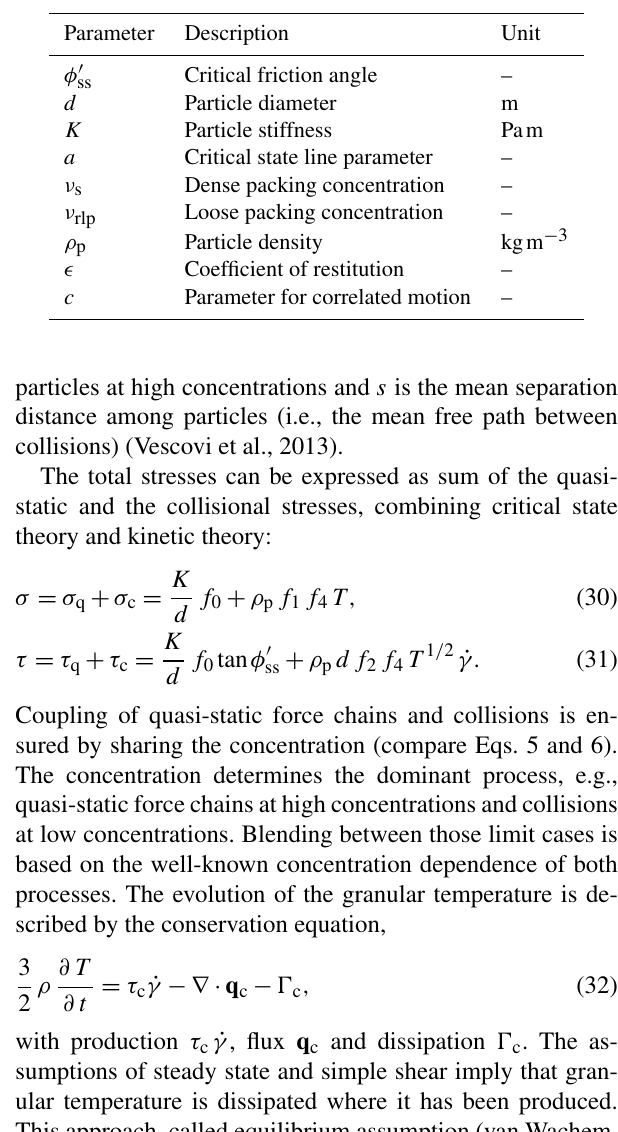
Table 1. Material parameters of the extended kinetic